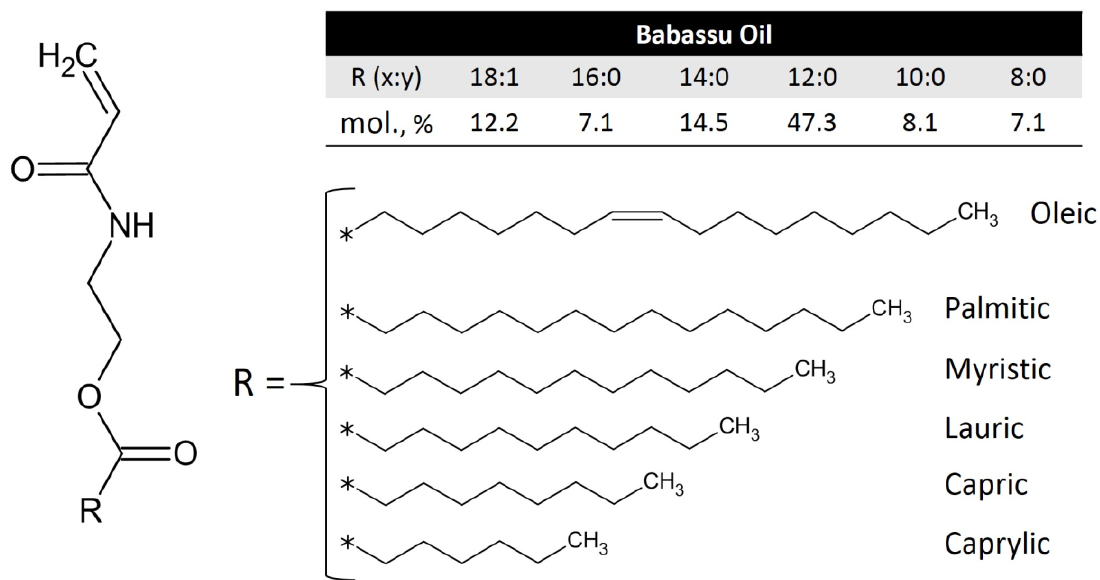
Figure 1. Chemical structure of babassu oil-based monomer (BBM) synthesized in this study. R (x:y) is the structure of the fatty acids (x is the number of carbon atoms in the fatty acid chain, and y is the number of double bonds in the fatty acid). * bond connecting the moiety to the monomer.